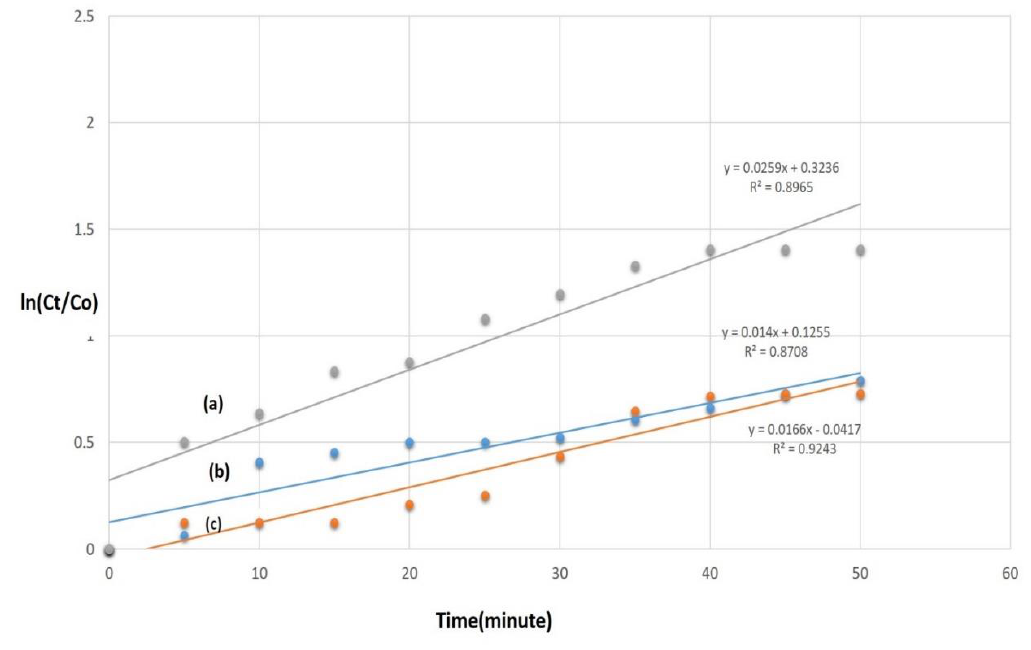
Figure 11. ( a ) The pseudo first order kinetics of 0.01Ag/TiO 2 composite. ( b ) The pseudo first-order kinetics of 0.1 Ag/TiO 2 composite. ( c ) The pseudo first-order kinetics of 0.5 Ag/TiO 2 Table 3. Kinetics study of photocatalytic reduction of Cr(VI) to Cr(III).